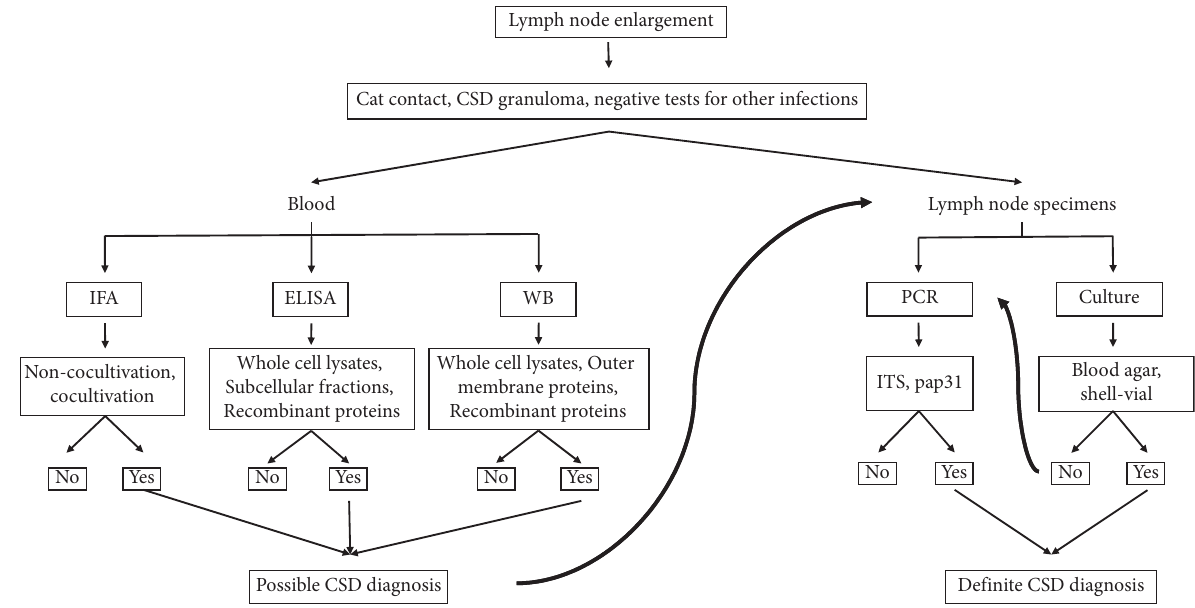
Figure 5: Recommendations of the diagnostic procedure of a potential CSD